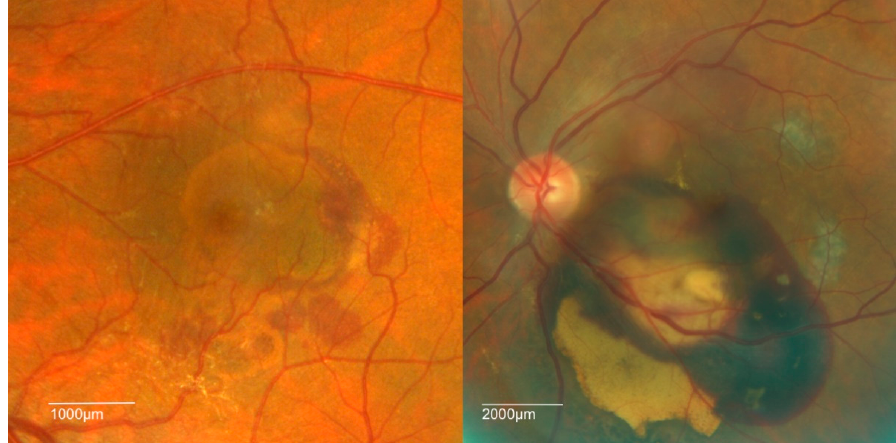
Figure 1. Fundus photographs showing the two clinical patterns of polypoidal choroidal vasculopathy (PCV): hemorrhagic ( right ) and serous ( left ).